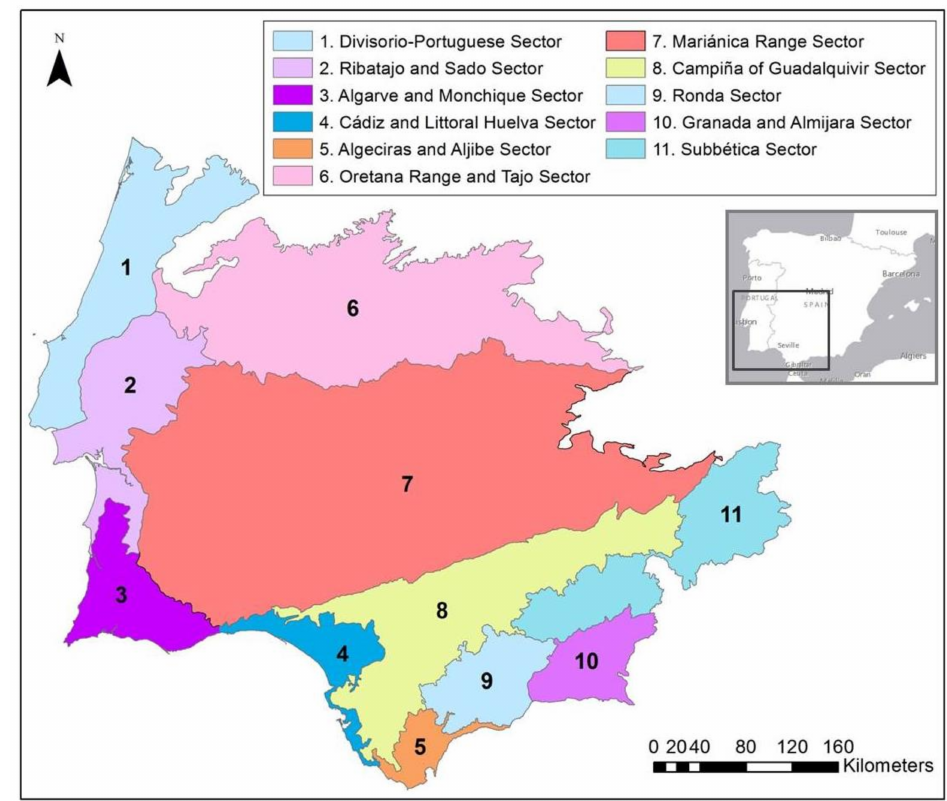
Figure 1. Biogeographical map of the southwest of the Iberian Peninsula at sector level, following Rivas-Mart í nez et al. [19]. Table 1. Synoptic table of southwestern Iberian Peninsula chasmo-chomophytic communities linked to the Rumici indurati- Dianthion lusitani and Calendulo lusitanicae-Antirrhinion linkiani alliances. Association